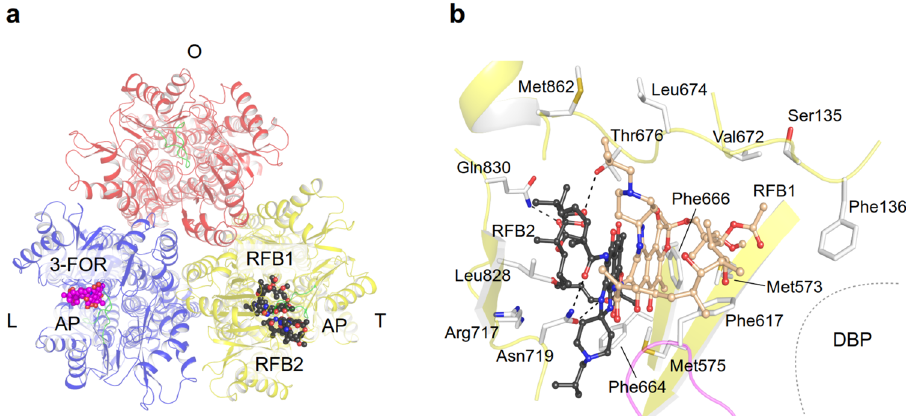
Fig. 4 Binding of HMW drugs to the access pocket of the L and T protomers. a AcrB porter domain top view with 3-formylrifamycin SV (3-FOR, carbon, magenta; oxygen, red; nitrogen, blue) and rifabutin (RFB1/RFB2, carbon, black) bound to the access pocket (AP) of AcrB adopted from two different AcrB co-crystal structures (PDB ID: 6ZOB, 6ZO9, respectively). Switch loop is colored in green. b Binding of two rifabutin (carbon, white (RFB1) or black (RFB2)) to the AP of the T protomer. The switch loop is coloured in magenta (DBP deep binding pocket).